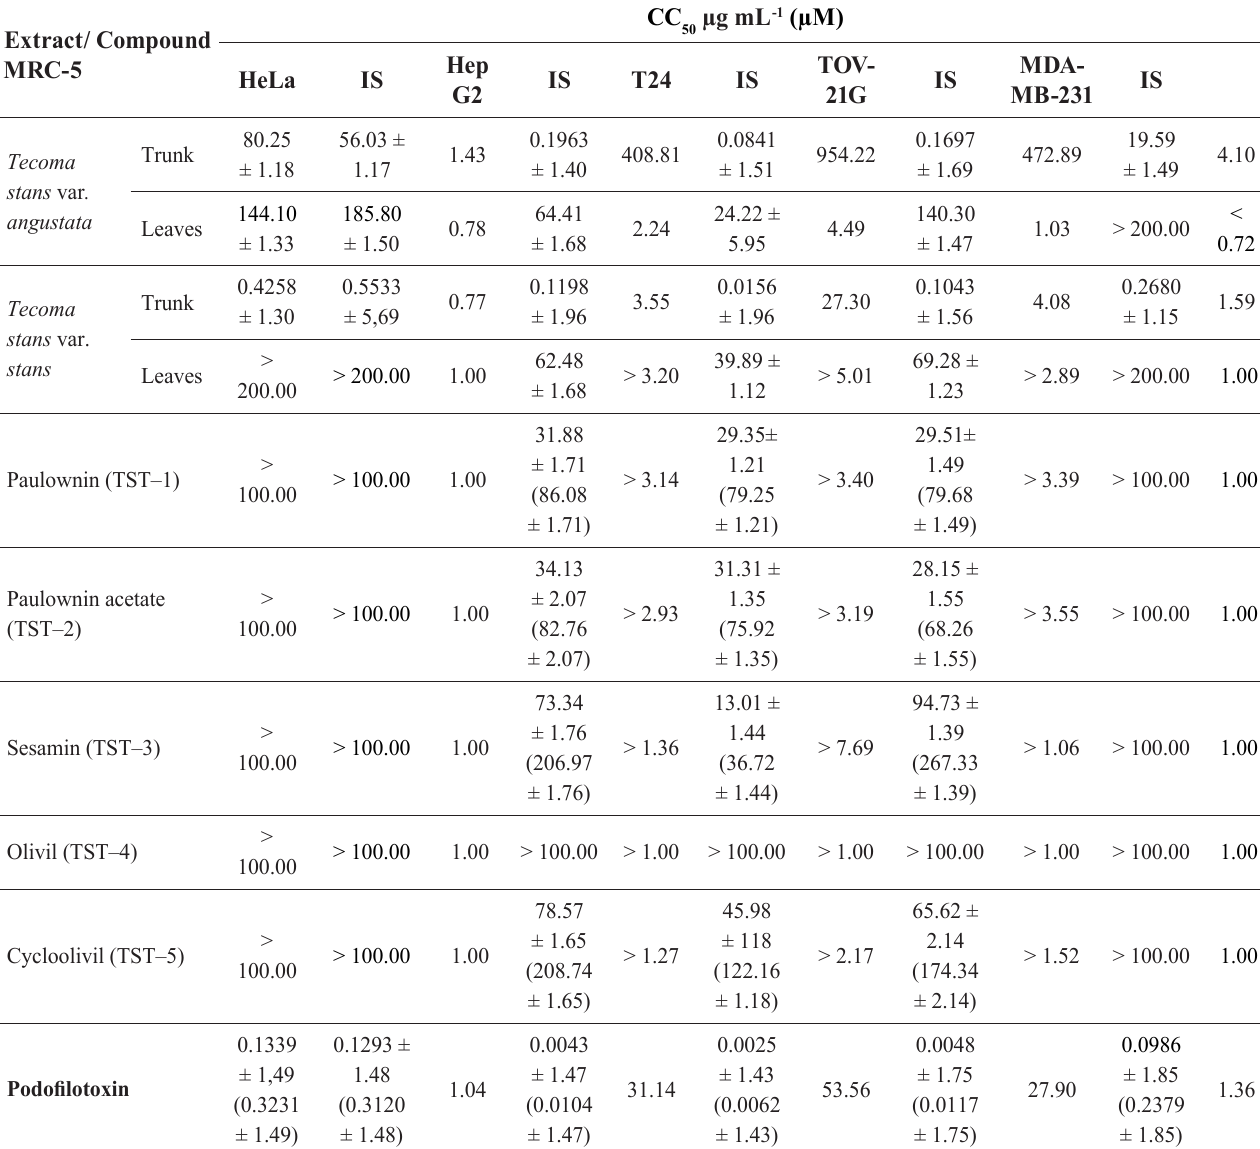
) of Tecoma species extract and lignans 50